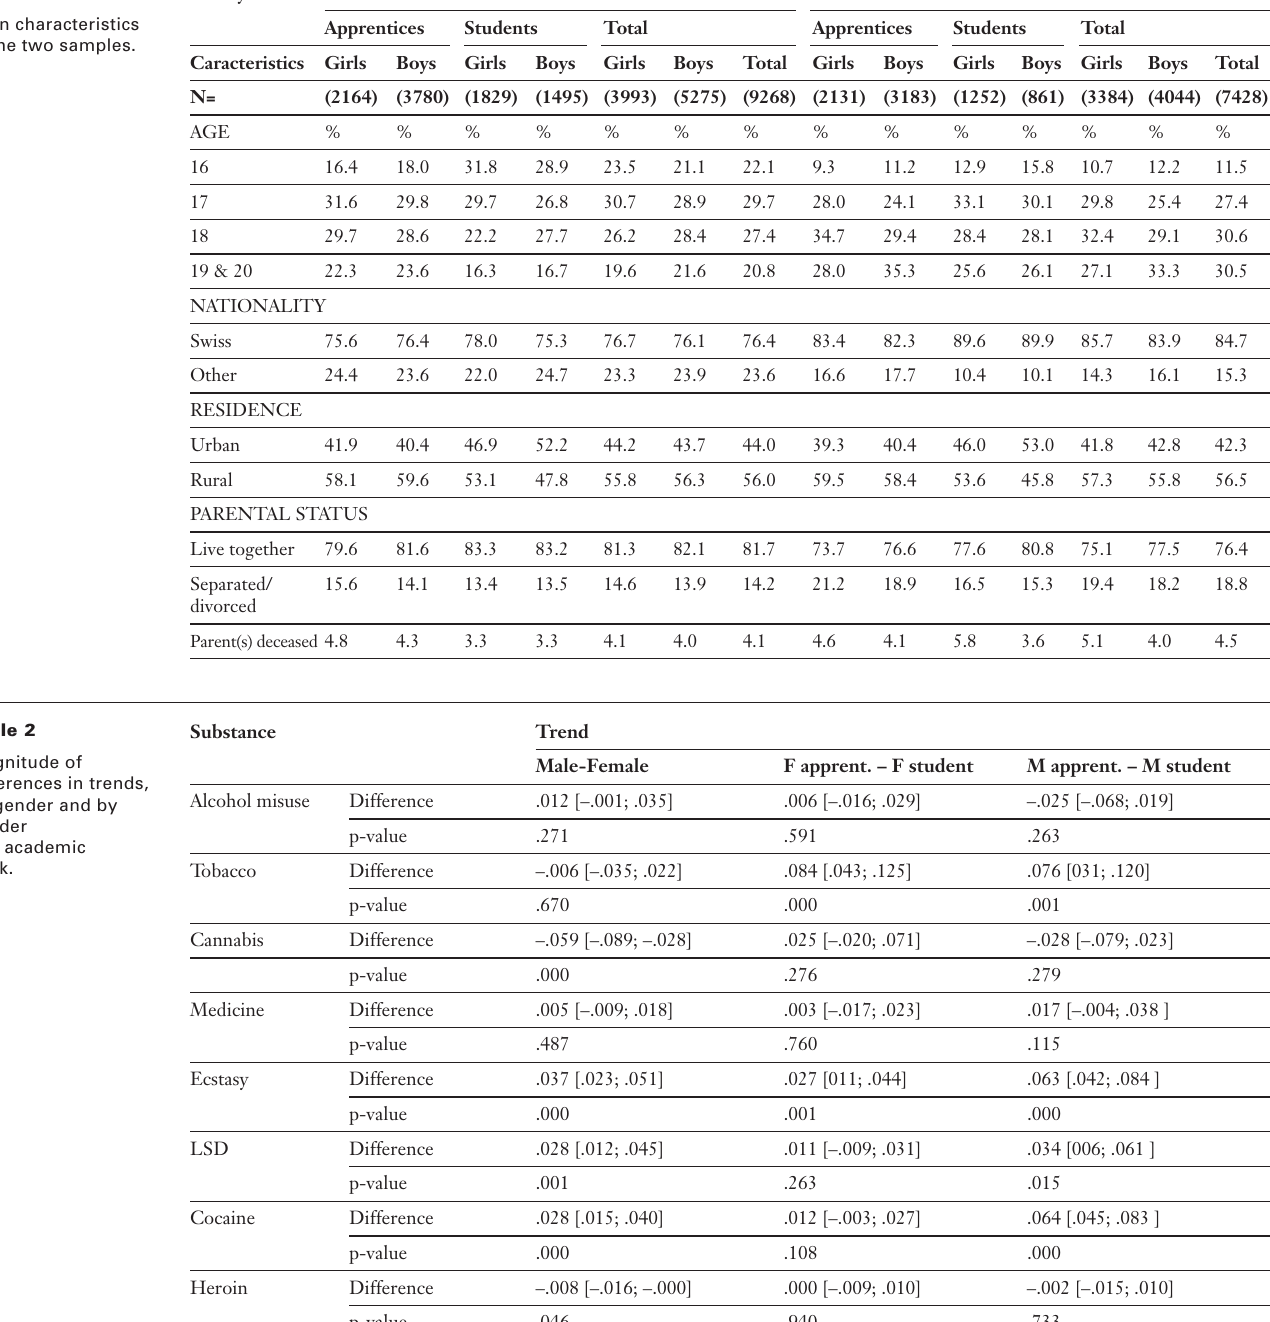
Main characteristics of the two samples.